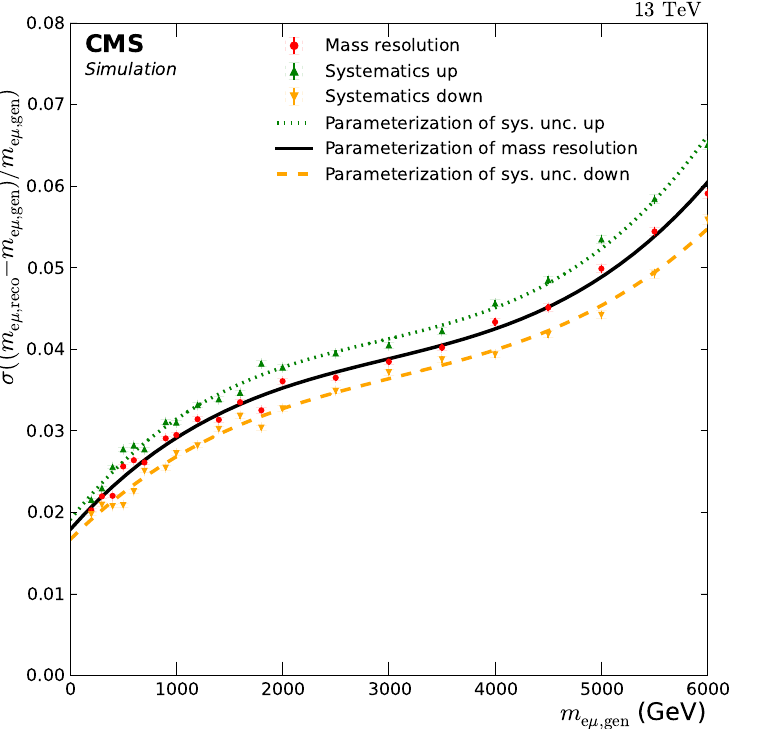
Figure 8 . Relative mass resolution for all e (cid:22) pairs, obtained through simulation of the RPV signal, from the reconstructed mass m e (cid:22); reco and the generated mass m e (cid:22); gen , as a function of the generated mass. The e(cid:11)ect of the systematic uncertainties on the mass resolution is shown. The systematically shifted upper and lower mass resolutions are shown in the (cid:12)gure with the corresponding parametrization for the upward shifts in dotted green and the downward shifts in dashed